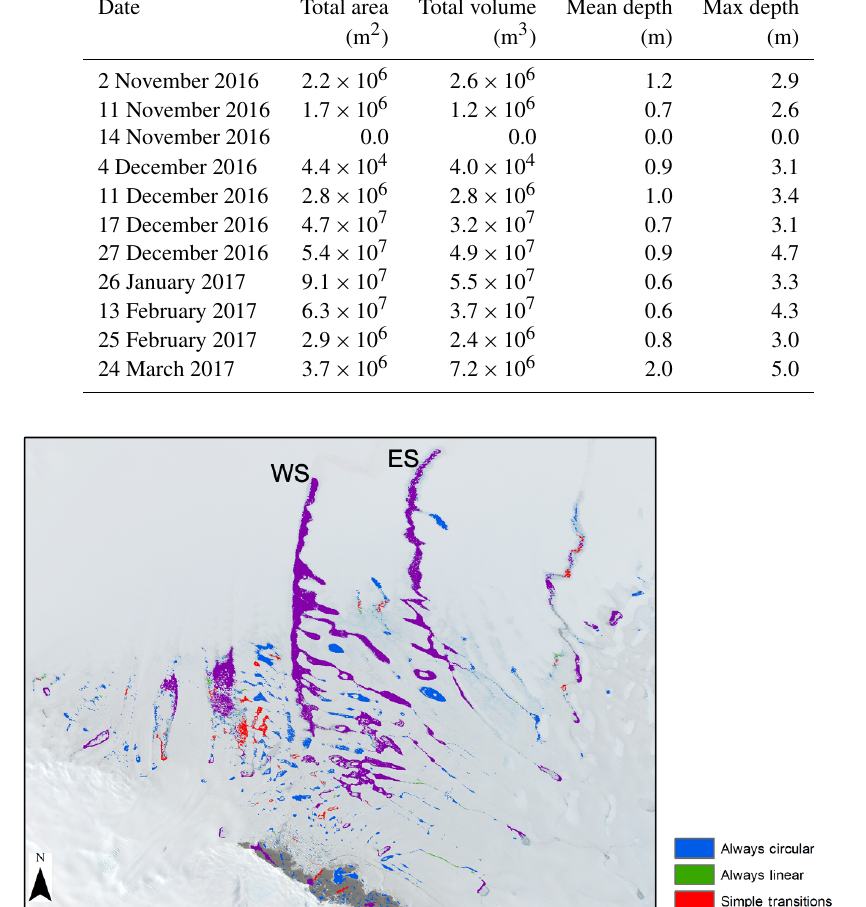
8 . 0 × 10 7 m 2 in area and 4 . 5 × 10 7 m 3 in volume on 26